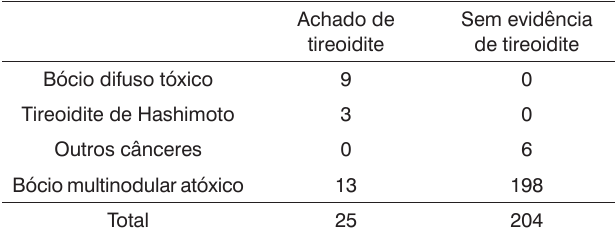
Tabela 1. Achado de tireoidite nos pacientes submetidos à